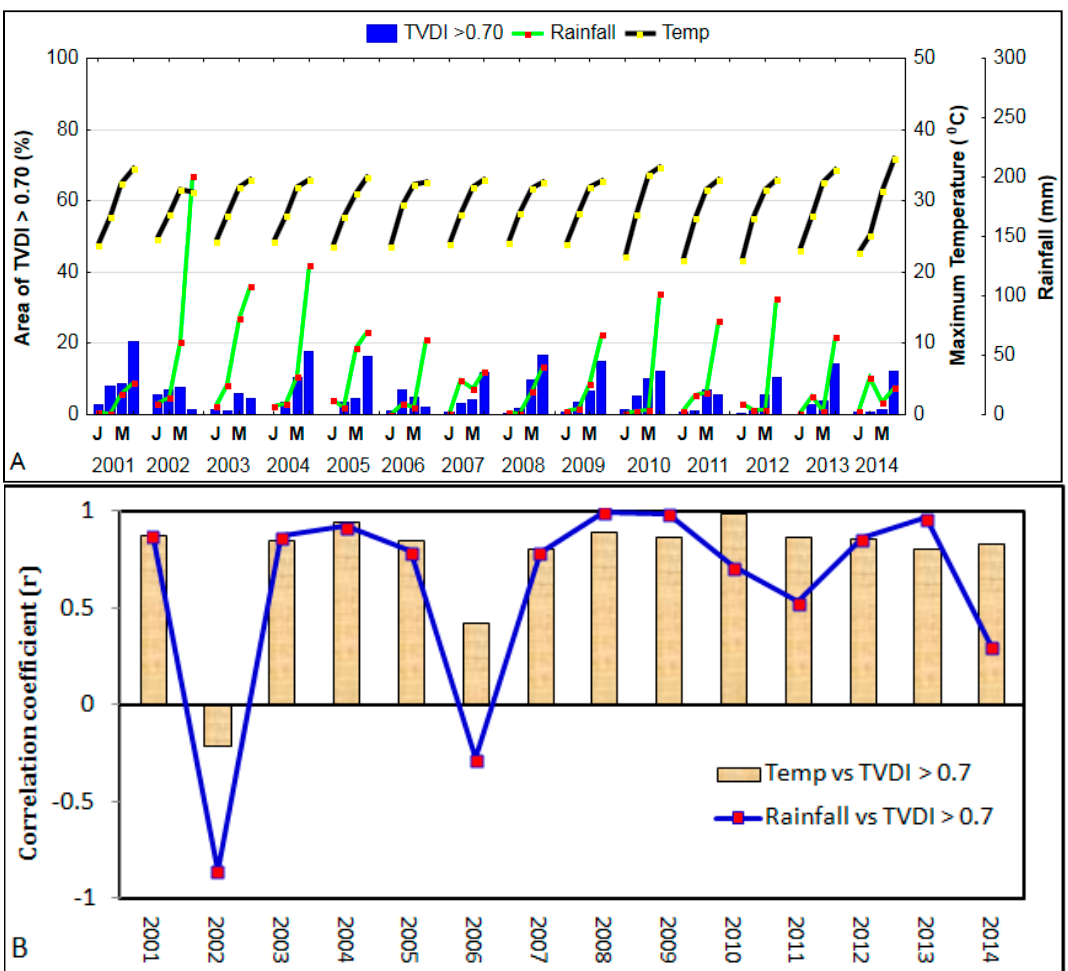
Figure 5. Relationship between highTVDI and temperature and rainfall. ( A ) is the integrated display of highTVDI area, rainfall and temperature where J indicates January and M indicates March. ( B ) is the correlation between area of highTVDI and temperature, as well as between highTVDI and rainfall.